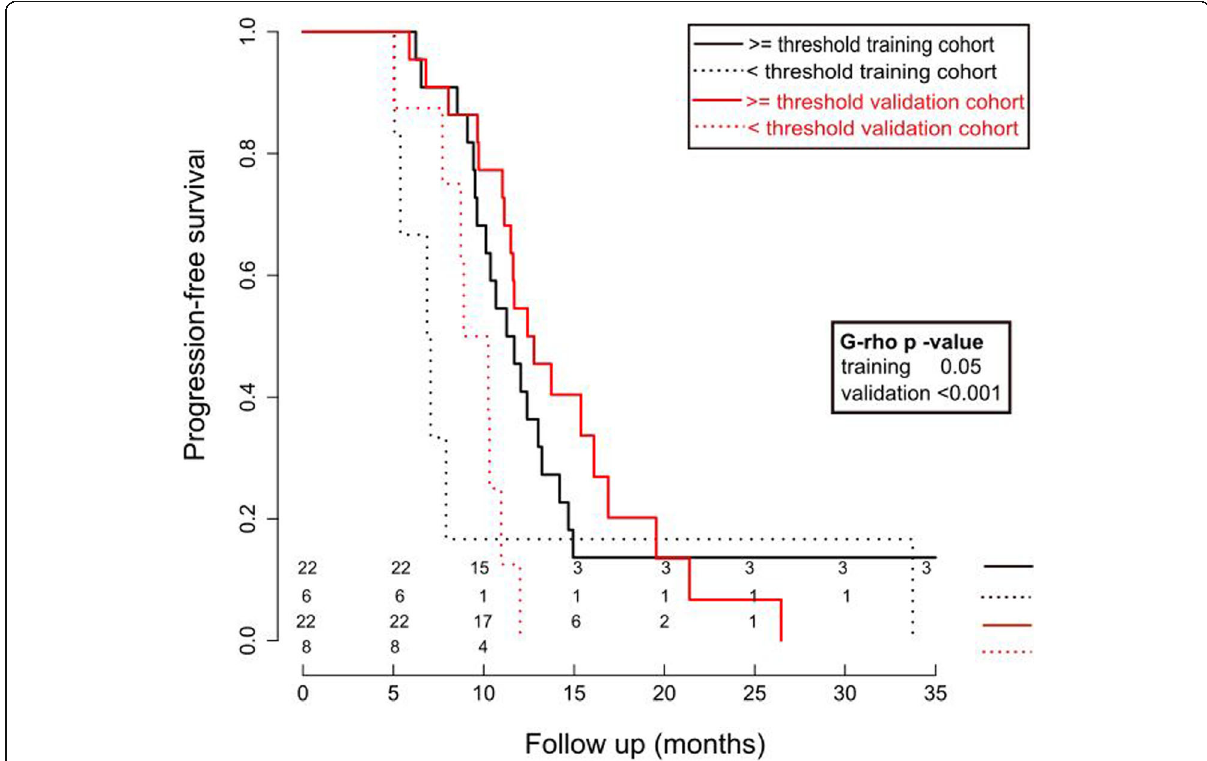
Fig. 2 Cox regression results for FDG PET radiomics model for